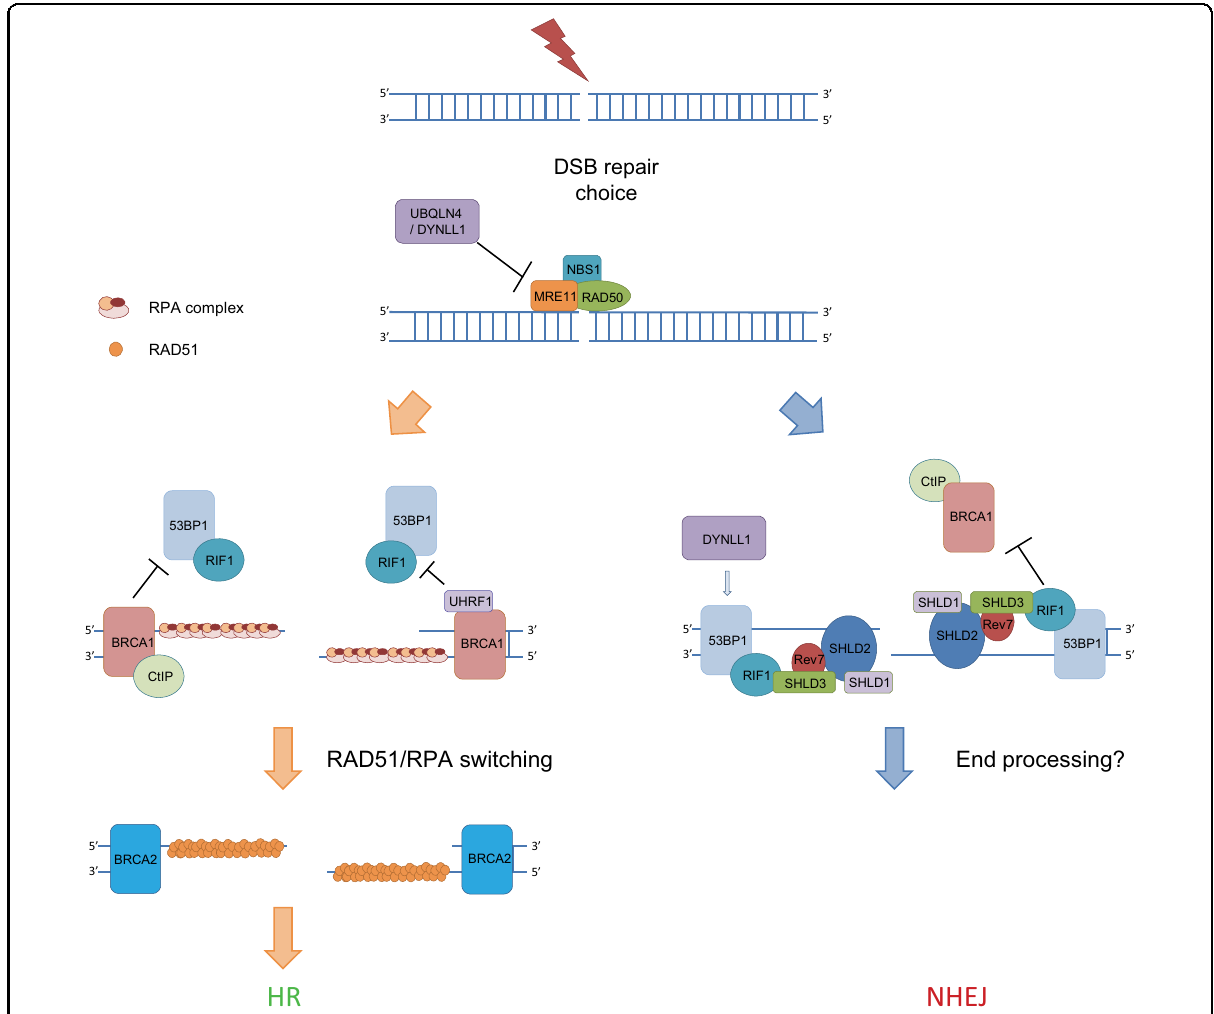
Fig. 3 DNA end resection and DSB repair choice. The current view of regulators involved in DNA end resection and DSB repair